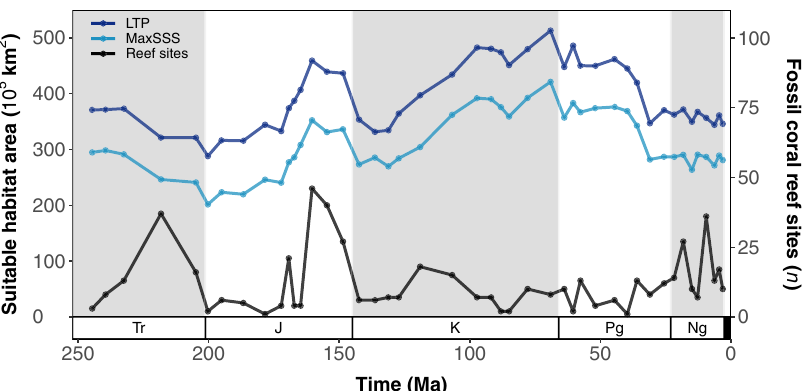
Fig. 5 Global estimates of suitable habitat area (Anisian to Piacenzian) for warm-water coral reefs under binary thresholds ‘ LTP ’ (least training presence; dark blue) and ‘ MaxSSS ’ (maximising the sum of sensitivity and speci fi city; light blue). Stage-level hindcasts are based on a modern-calibrated MaxEnt model, and area is calculated from binary predictions (LTP/MaxSSS). The number of fossil warm-water coral reef sites is depicted in black. Ordinary least-squares regression analyses suggests that there is no signi fi cant relationship between the number of fossil coral reef sites and the availability of climatically suitable habitat (see Fig. S11). Period abbreviations are as follows: Triassic (Tr), Jurassic (J), Cretaceous (K), Paleogene (Pg), and